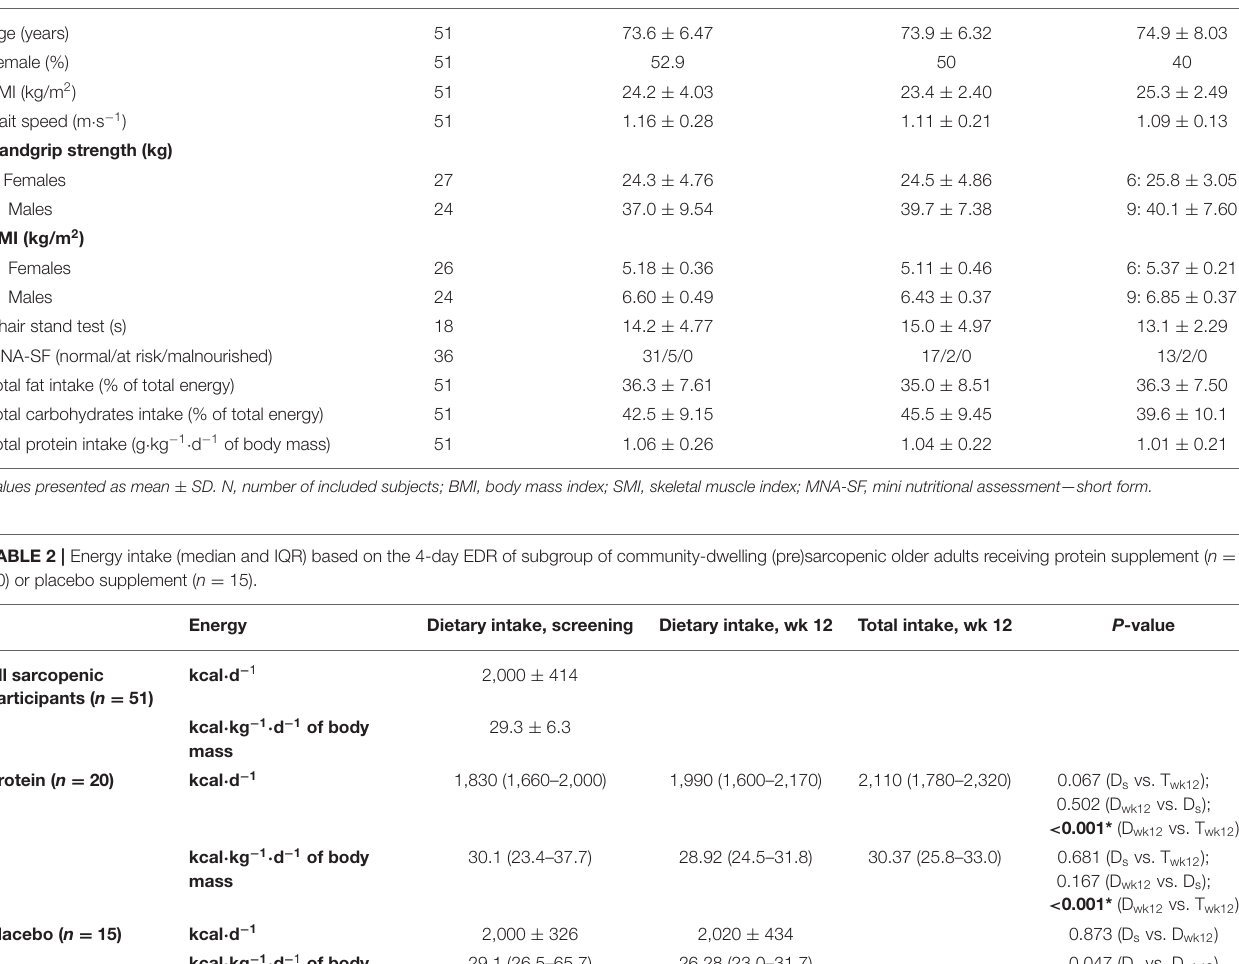
( Table 4 ). At screening, the regular dietary distribution of leucine intake at breakfast, lunch, dinner and snack times was unequal, and no meal reached the 2.5 g leucine threshold